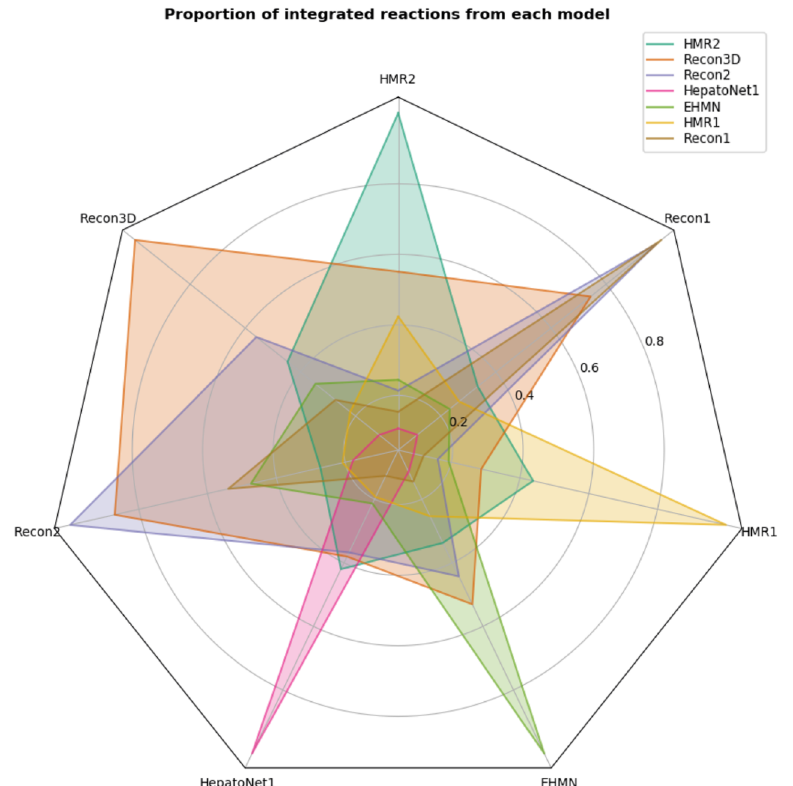
Figure 10: Radar plot representing the proportion of reactions that each model contains from the others. Each coloured polygon represents a single model and each of its vertices represent the proportion of reactions shared by other models. This proportion is always 1 in the vertex associated with its own model. Recon3D, as expected, is the model that contains more information from all the other